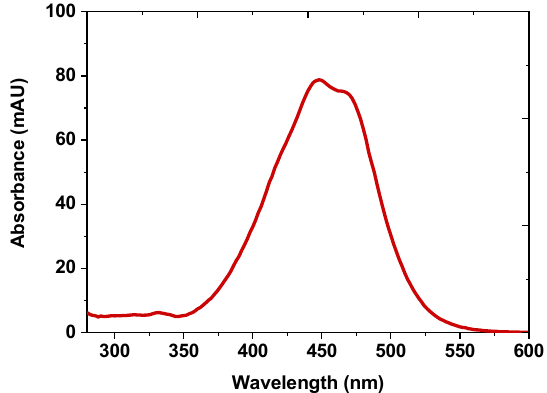
Figure 8. UV-vis spectra of purified fucoxanthin form N. shiloi.